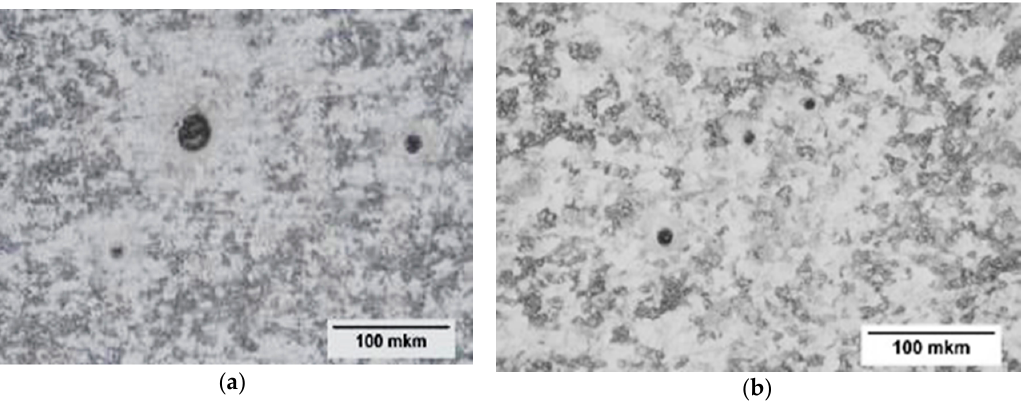
Figure 3. Typical SEM images of corrosion active non-metallic inclusion in steel samples after etching: ( a ) from Heat A; ( b ) from Heat B.